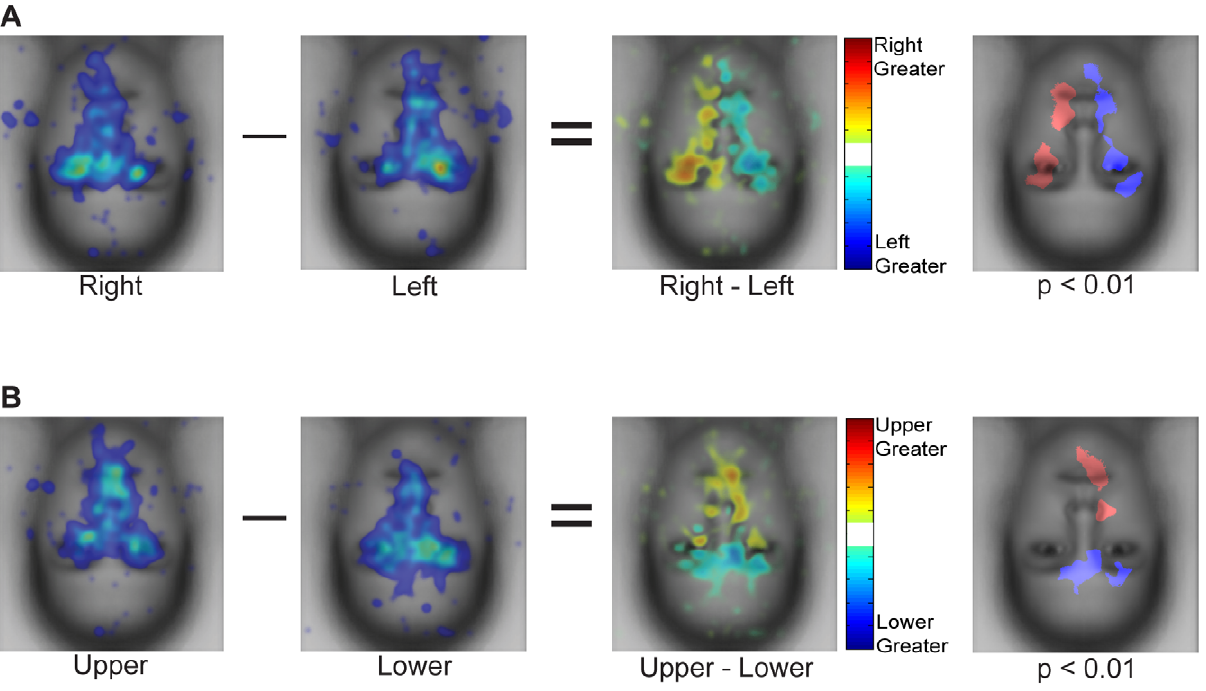
Figure 10. Direct comparison of spatial distributions of fixations for different start positions on inverted faces. ( a ) Contrast between right and left start positions. All conventions are the same as in Figure 7. Note the symmetrical advantage for the side of face opposite the start position as with upright faces. ( b ) Contrast between upper and lower start positions. Note, again, the advantage for the side of the face opposite the start position.